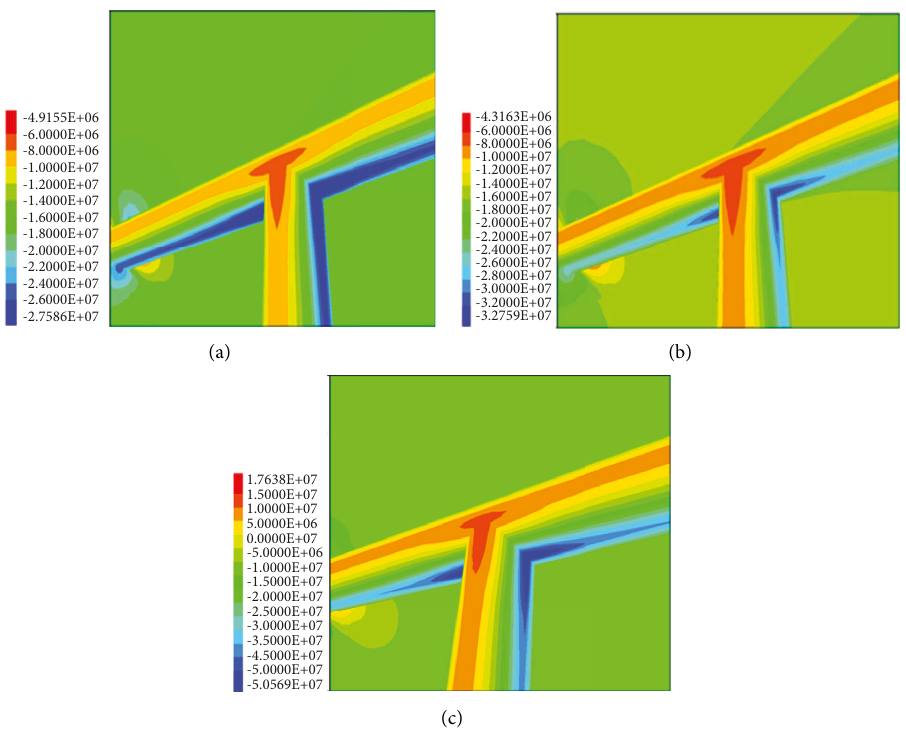
Figure 8: Stress field contrast diagram, (a) original support system, (b) high prestressed constant resistance coupling support system, and (c) dual-control constant-resistance coupling control system.